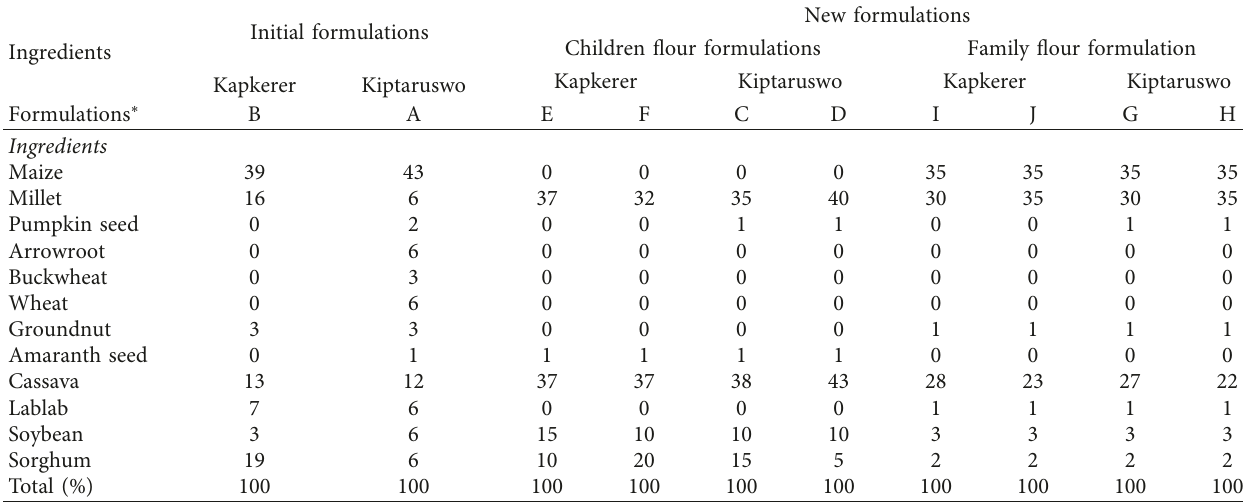
Table 1: Legume-cereal-root based flour formulation (%) for family and school-going children. Ingredients